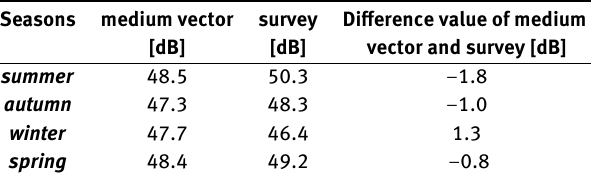
Table 3: The results of fuzzy set and fuzzy relations connection. Table 5: Summary of noise level differences generated by the fuzzy analysis and Noise